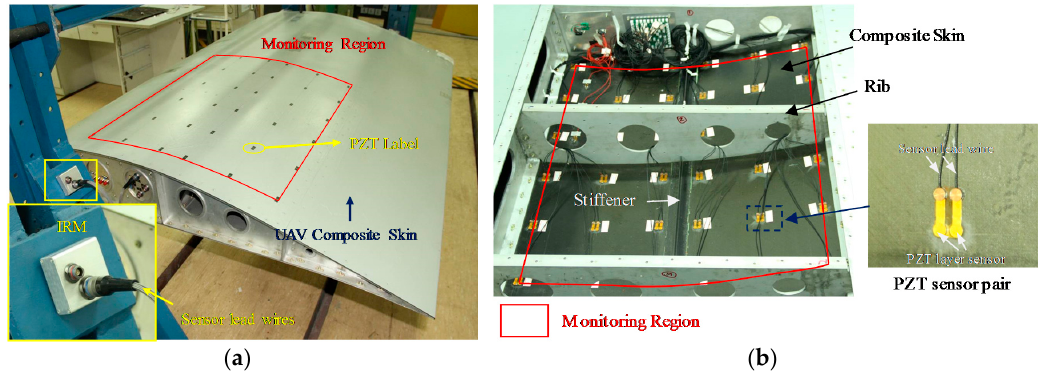
Figure 22. The UAV composite wing box, IRM and sensor placement: ( a ) The UAV composite wing box and the IRM and ( b ) Sensor placement.